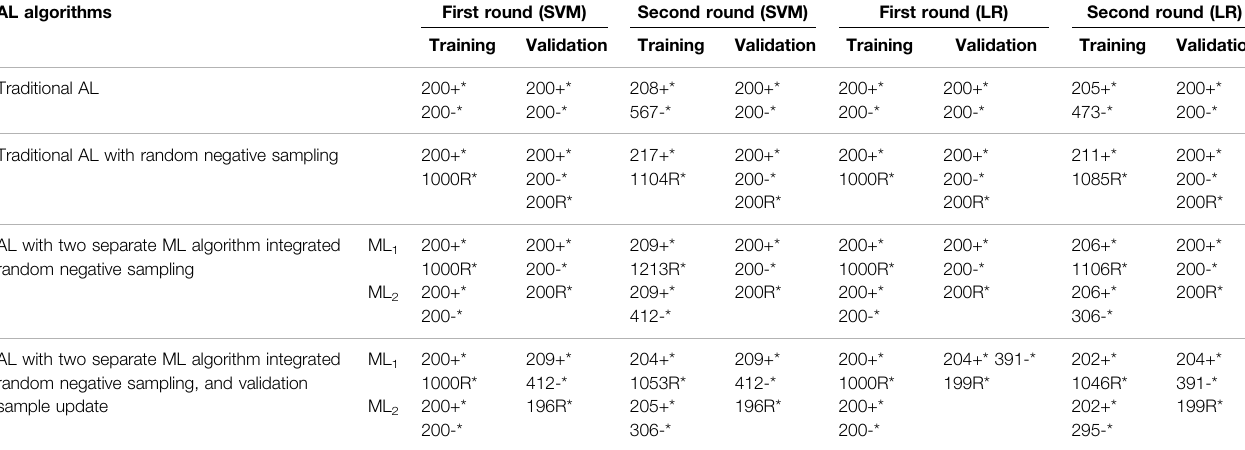
TABLE 2 | Training and validation sample sizes for four different active learning (AL) methods in two